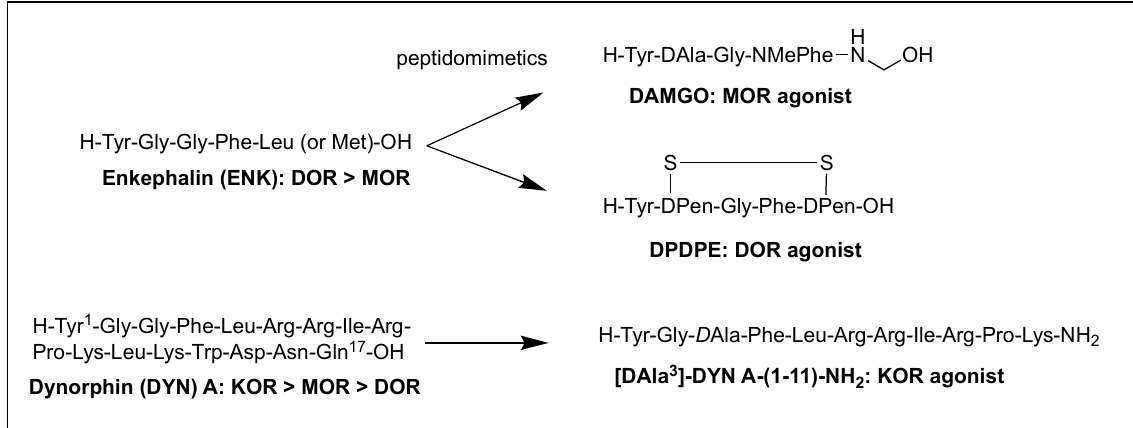
Figure 1. Subtype selective opioid peptidomimetics developed from endogenous opioid peptides.